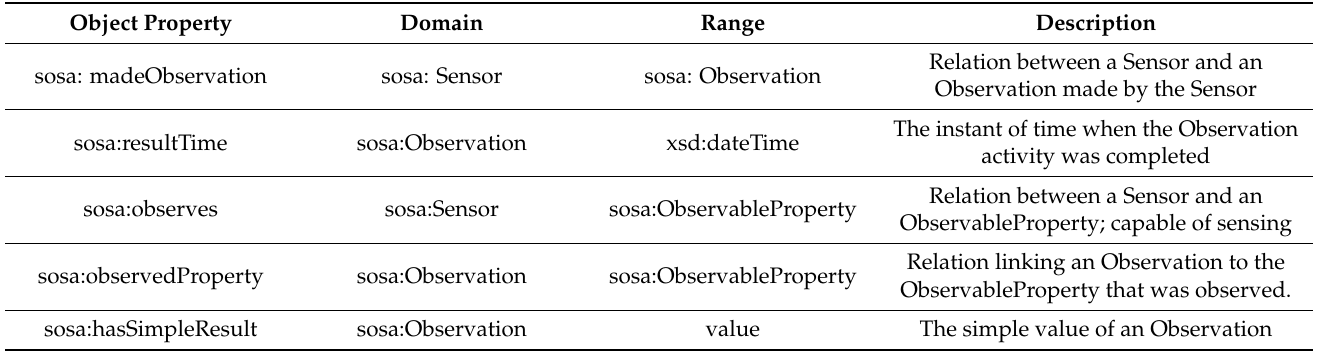
Figure 3. Top situation model classes for mapping IoT sensor data. Table 3. The object properties, domain, range, and the description of main object properties.